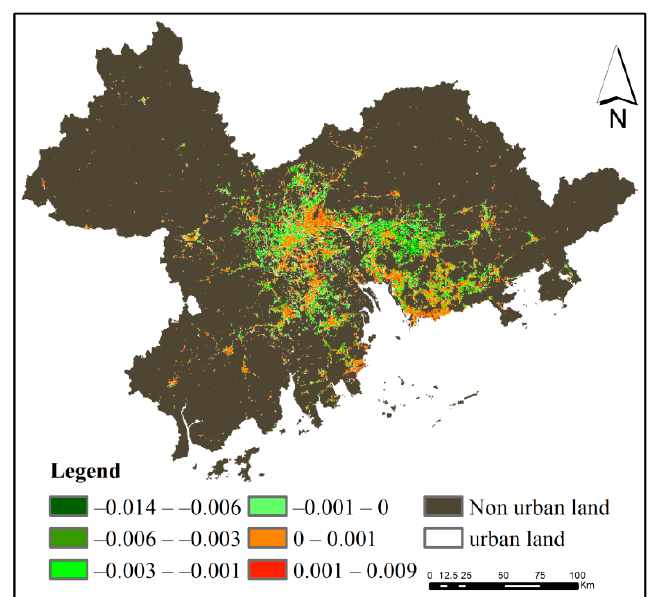
Figure 15. Vegetation change in urban